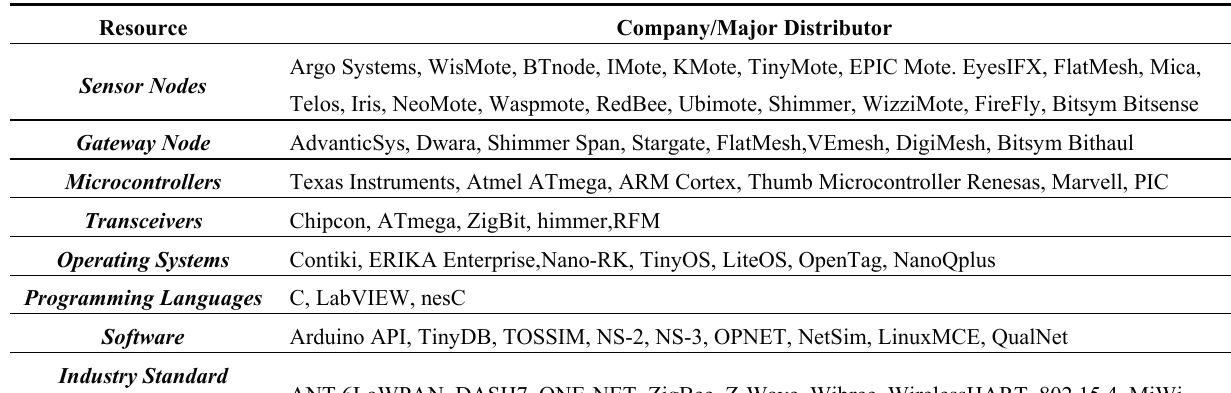
Table 1. Popular WSN platforms available for industrial and academic use